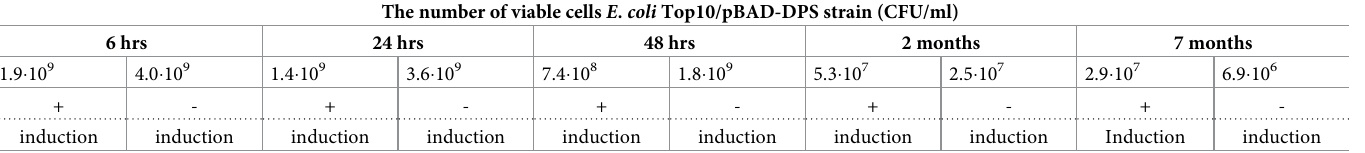
Table 1. Viable cell number decrease upon starvation.